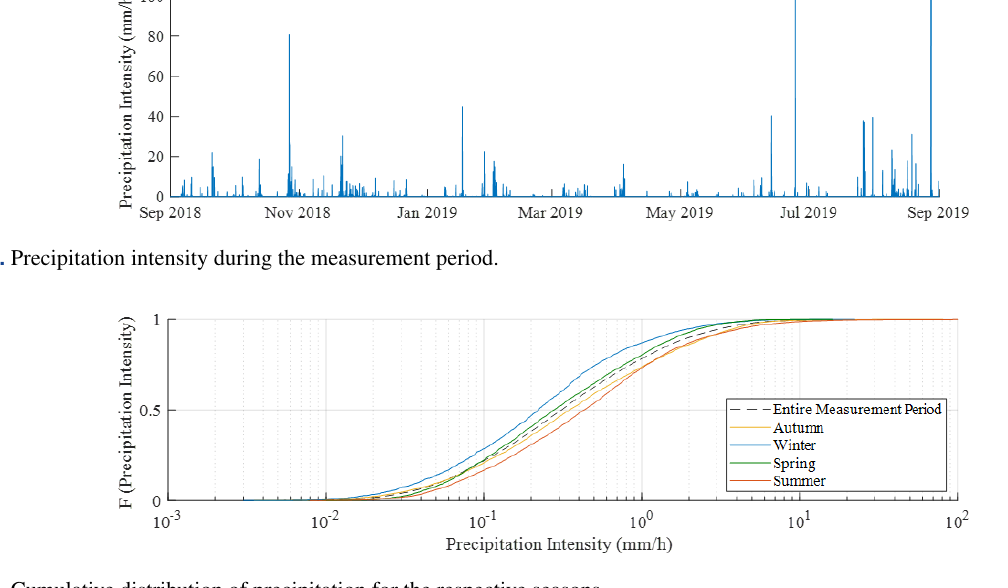
Figure 3. Cumulative distribution of precipitation for the respective seasons.